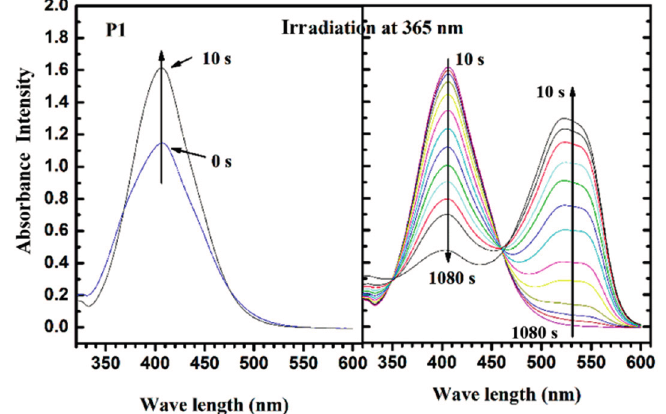
Figure 11. The UV-vis absorption changes of the linear poly( ε -caprolactone) (P1, M n GPC = 7400 g/mol, M w / M n = 1.15) during the irradiation with 365 nm UV light in chloroform solution (The concentration of azobenzene moieties is 5.00 × 10 − 5 M at room temperature). The arrows means that the time go on and the absorbance intensity decreased or